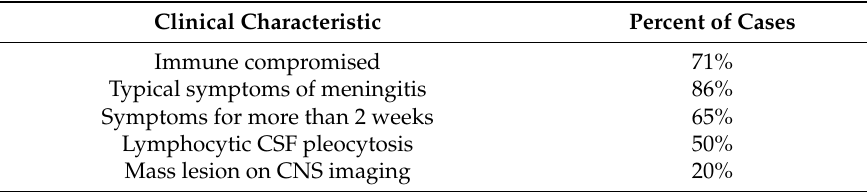
Table 1. Summary of most common clinical characteristics of patients with CNS histoplasmosis (modified from reference